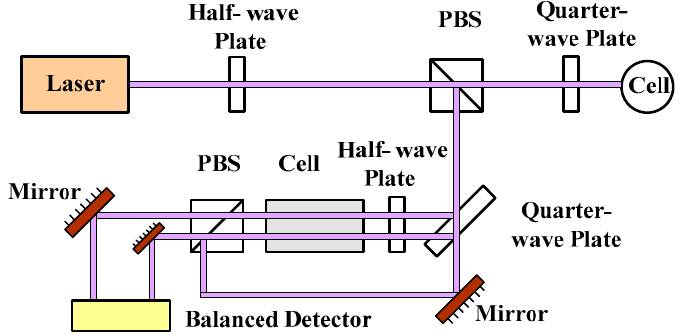
Figure 7. Schematic diagram of the frequency stabilization based on the saturation absorption method.